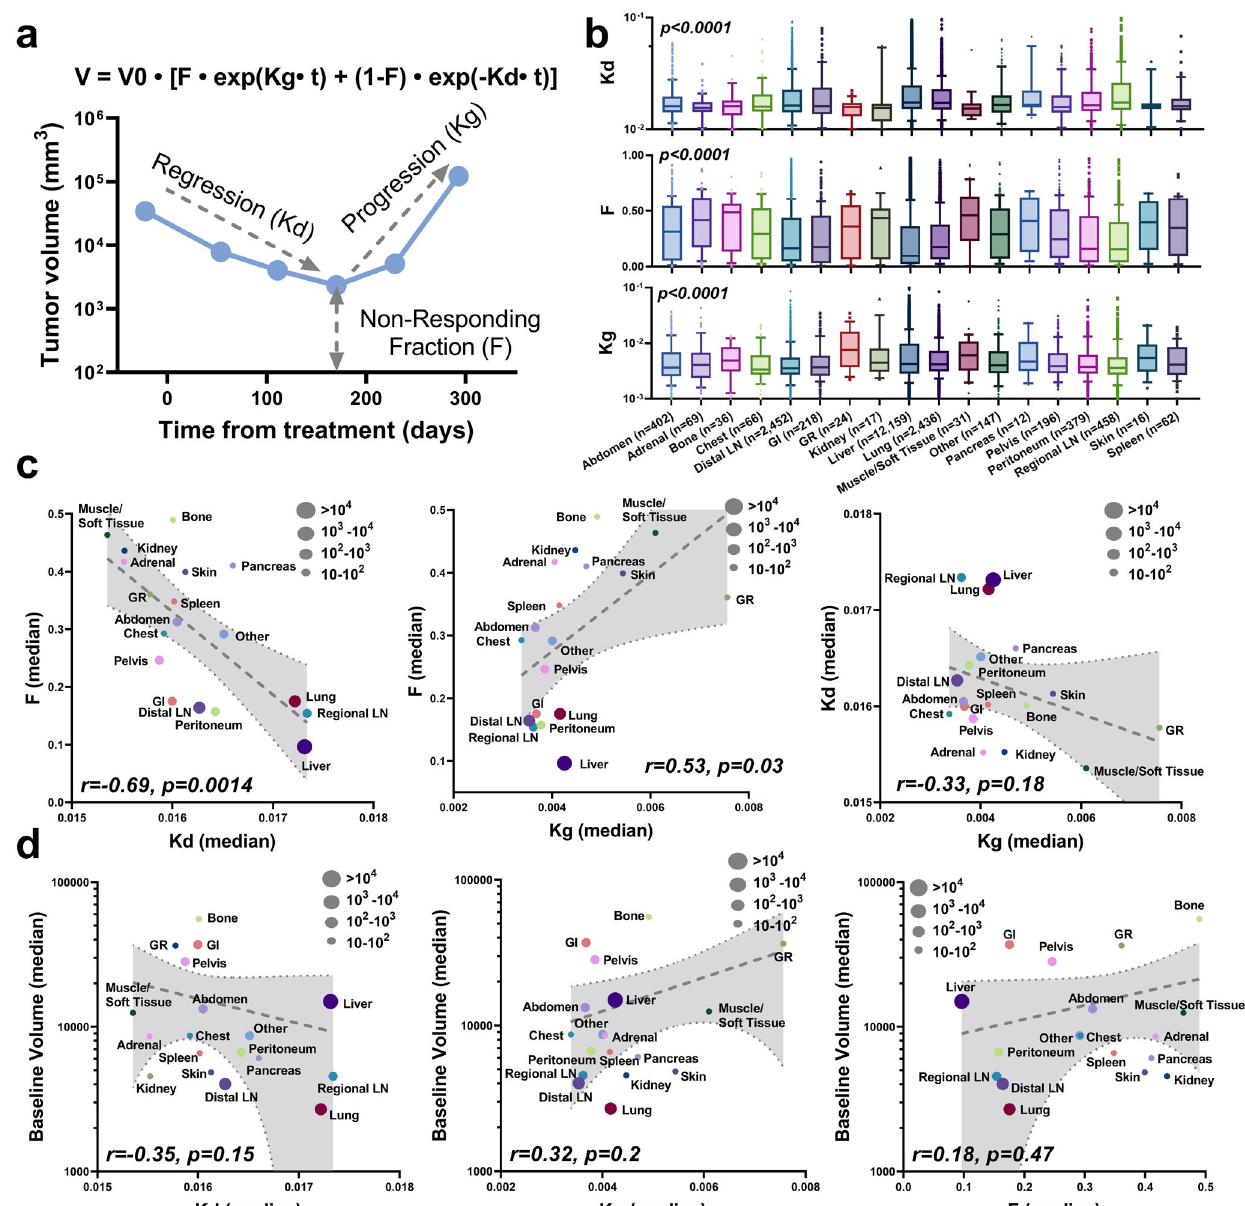
Fig.2|Tumorresponsedynamicswererecapitulatedbymodeling.a Schematic plot of tumor growth model. b Box plots of model parameters Kd , F and Kg across